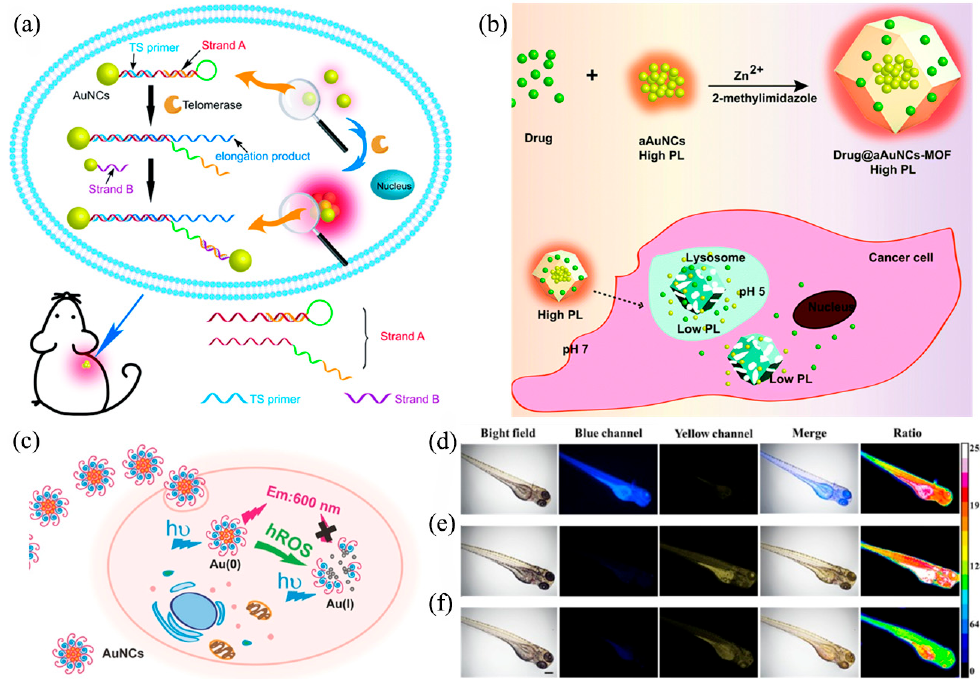
Figure 7. ( a ) Mechanism model of telomerase-induced nanocluster assembly. Reprinted/adapted with permission from Ref. [70]. 2021, copyright Royal Society of Chemistry. ( b ) Mechanism model of drugs encapsulated into Au NCs-MOF. Reprinted/adapted with permission from Ref. [63]. 2017, copyright Royal Society of Chemistry. ( c ) Mechanism model of the one-step preparation of red-emitting Au NCs. Reprinted/adapted with permission from Ref. [73]. 2018, copyright Wiley-VCH. ( d – f ) Selectivity of CNC@GNCs RFP for hROS in vivo of different Zebrafish. Reprinted/adapted with permission from Ref. [74]. 2022, copyright